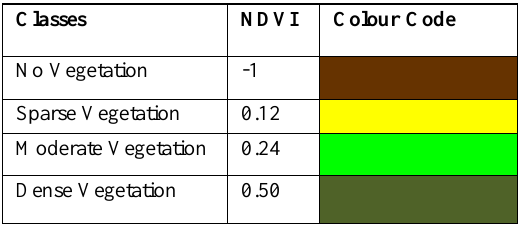
Figure 3. Classes versus NDVI values for the study area